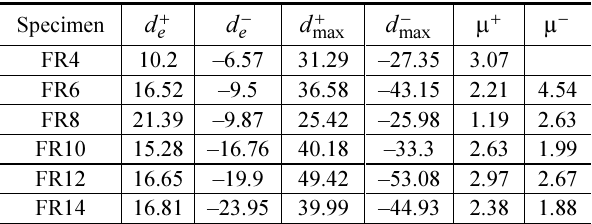
Fig. 6. Definition of effective stiffness K e and ductility parame- Table 2. Comparison of ductility factors µ based on hysteresis response for positive and negative direction